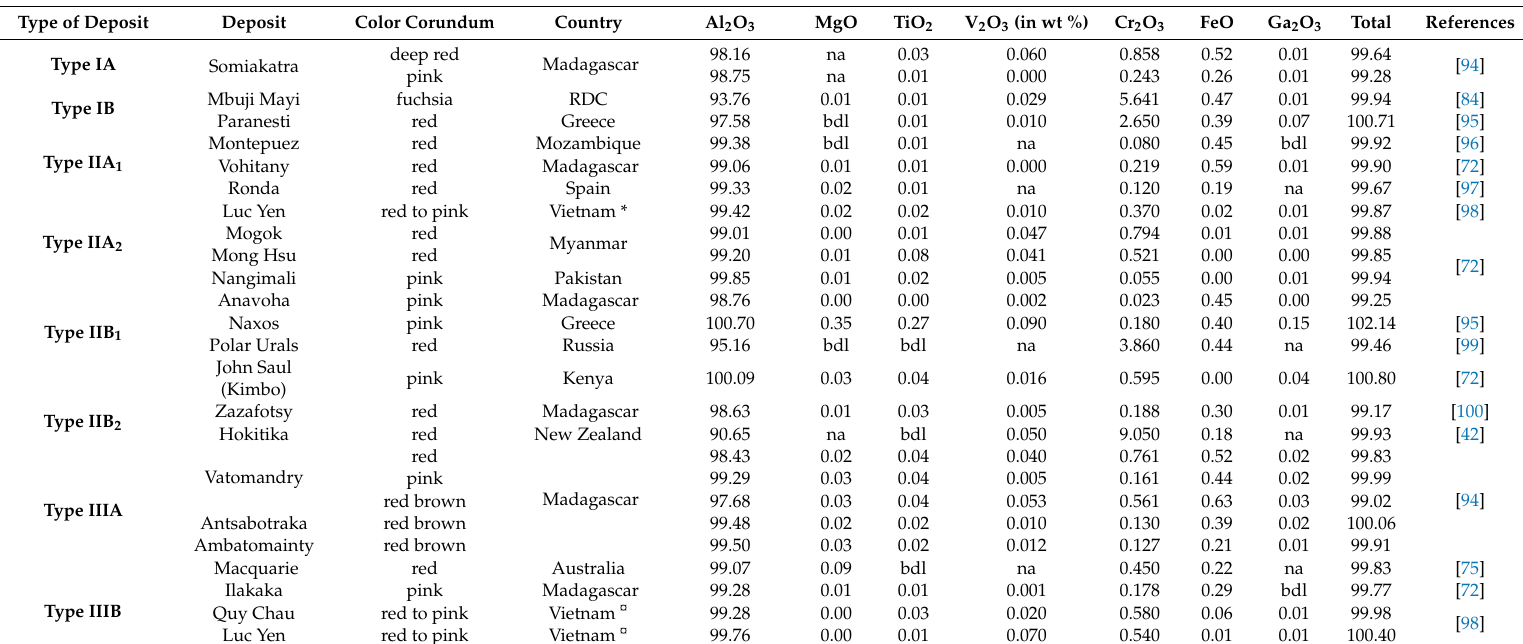
Table 1. Representative oxide (wt %) EMPA analyses of rubies originating from deposits of di ff erent geological types relative to the new enhanced geological classification for